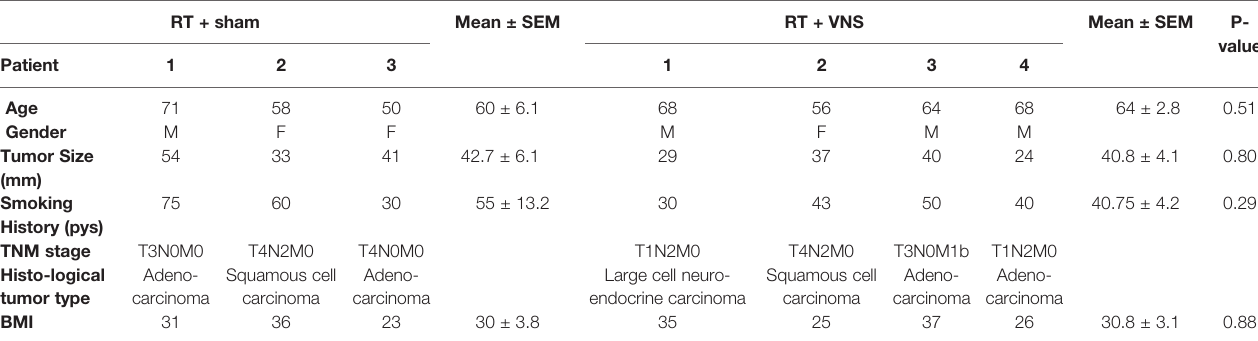
TABLE 1 | Patients characteristics at